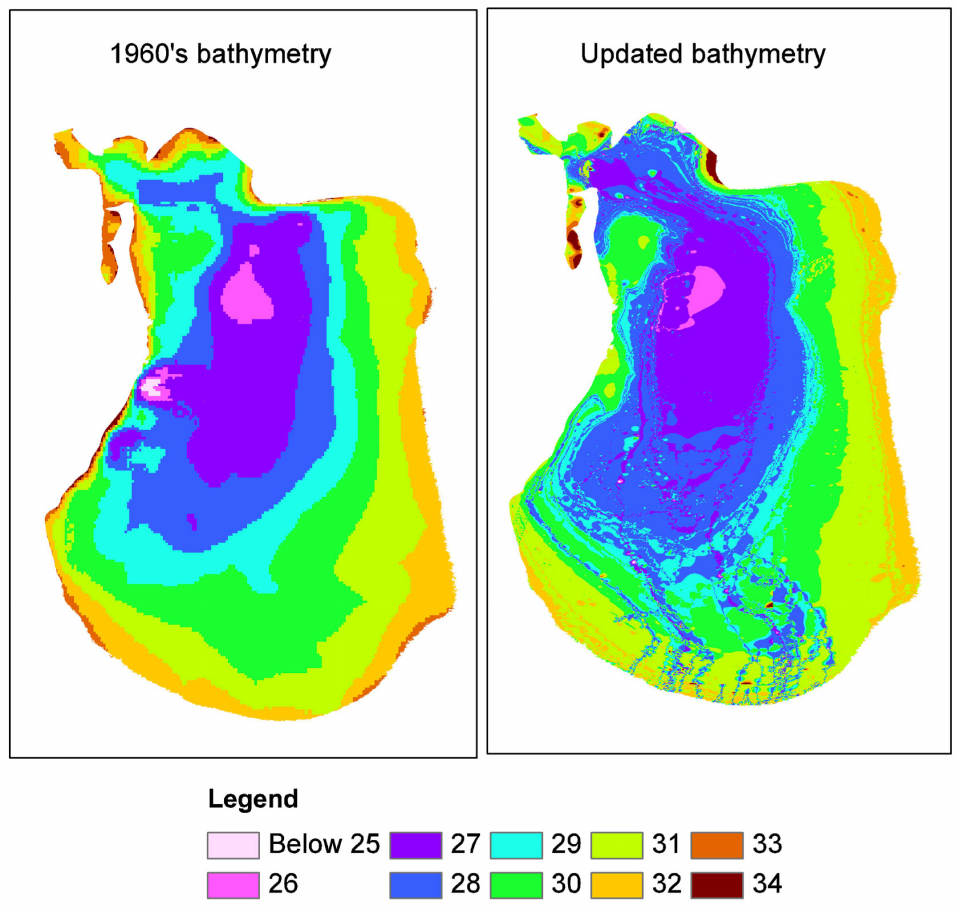
Figure 12. East Aral Sea. ( Left ) subset of the 1960s Aral Sea bathymetry; ( Right ) updated